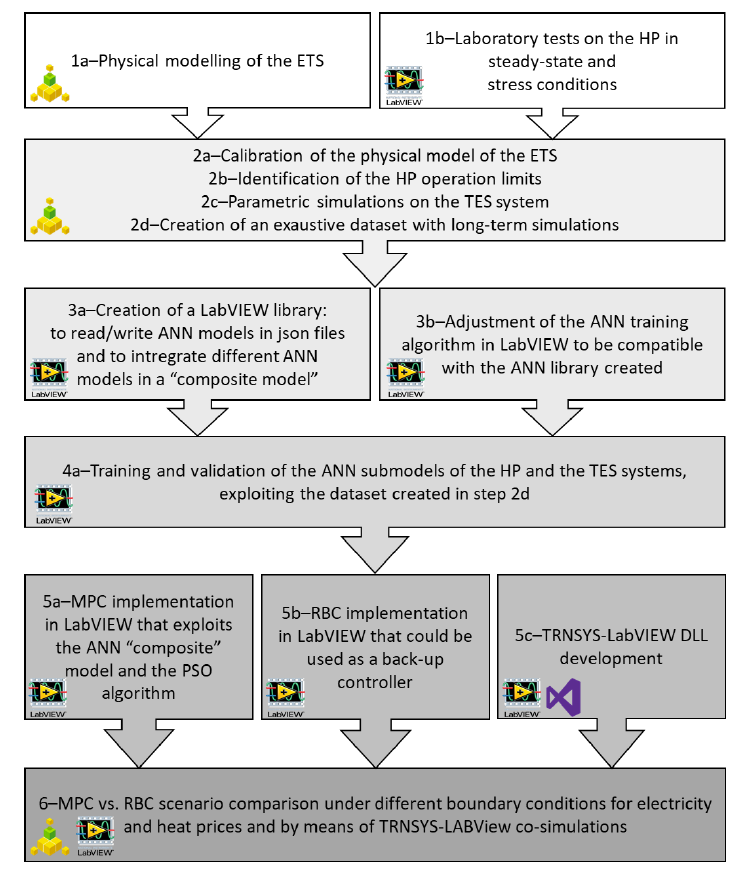
Figure 2. Flowchart of the different activities performed to develop and test the artificial neural network-based model predictive control (ANN-based MPC). ETS: energy transfer station, PSO: particle swarm optimisation, RBC: rule-based controller, and DLL: dynamic link library.